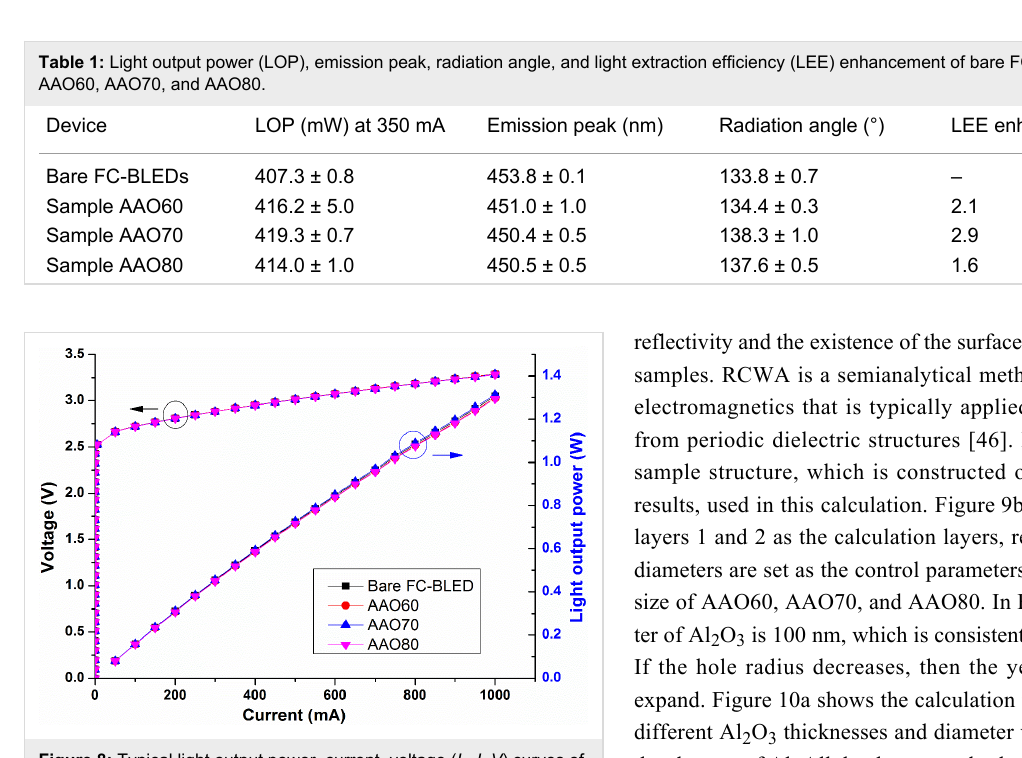
Figure 8: Typical light output power–current–voltage ( L – I – V ) curves of the samples in this study.